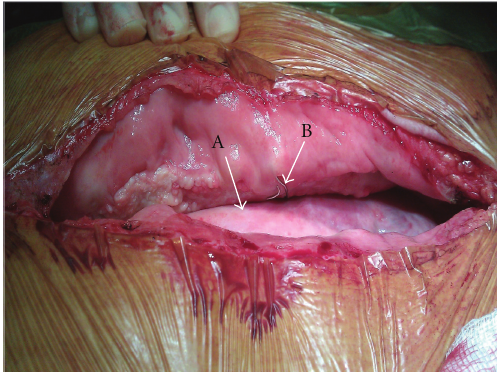
Figure 3: Intraoperative pictures of sternal dehiscence with Lung parenchyma (Arrow A) coming in contact with sternal wire (Arrow B).